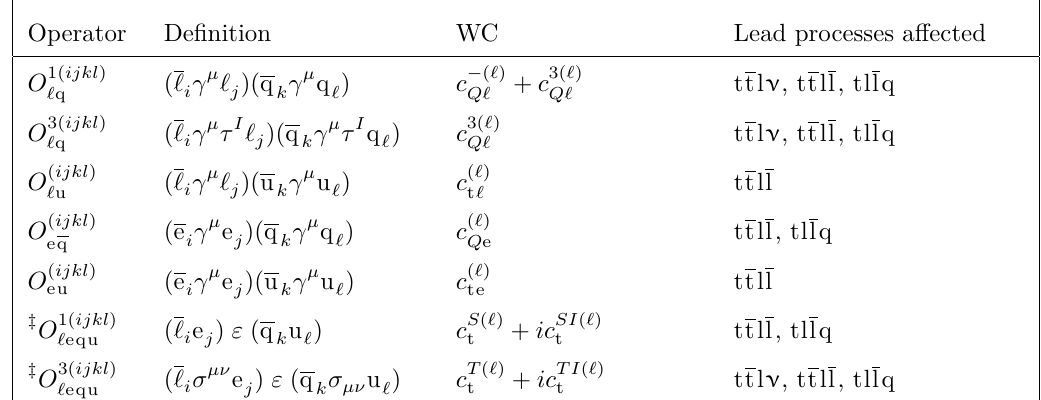
Table 1 . List of operators that have effects on ttH , ttll , ttl (cid:23) , tllq , and tHq processes at order 1 / Λ 2 that are considered in this analysis. The couplings are assumed to involve only third-generation quarks. The quantity T A = 1 λ A denotes the eight Gell-Mann matrices, and τ I are the Pauli 2 matrices. The field ϕ is the Higgs boson doublet, and ˜ ϕ = εϕ ∗ , where ε ≡ iτ 2 . The ‘ and q represent the left-handed lepton and quark doublets, respectively, while e represents the right- handed lepton, and u and d represent the right-handed quark singlets. Furthermore, ( ϕ † i ←→ ϕ † ( iD ϕ ) − ( iD ϕ † ) ϕ and ( ϕ † i D I ϕ ) ≡ ϕ † τ I ( iD ϕ ) − ( iD ϕ † ) τ I ϕ . The W boson field strength µ µ µ µ µ